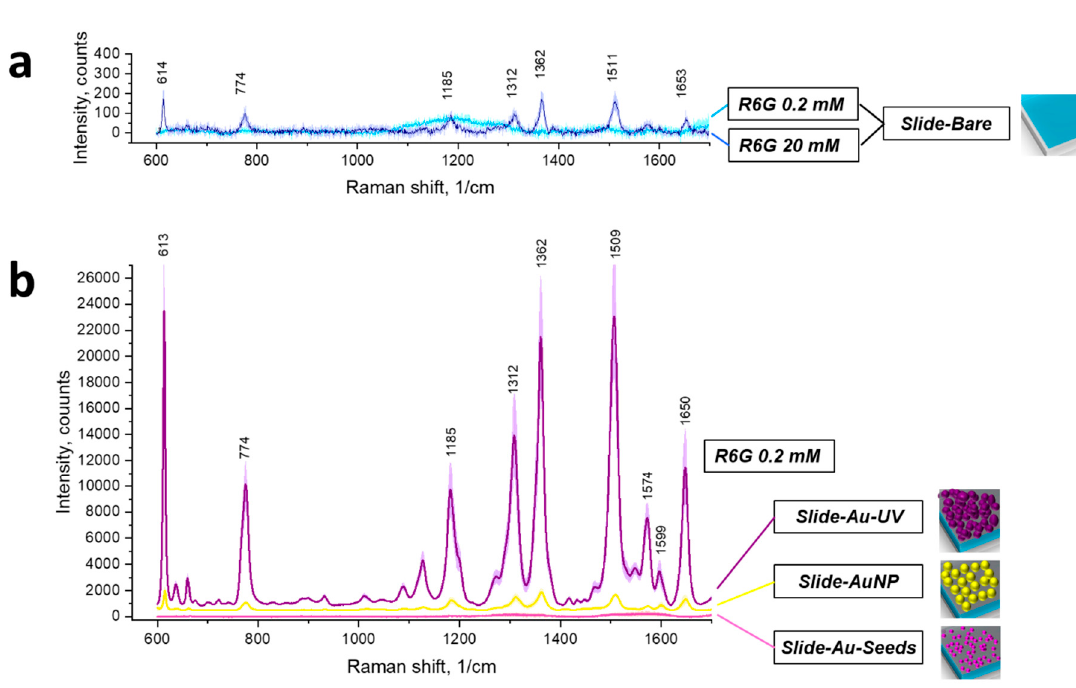
Figure 3. Raman and SERS of Rhodamine 6G (R6G) on planar glass substrates: ( a ) R6G at concentrations 0.2 and 20 mM on a bare glass slide; ( b ) R6G at concentration 0.2 mM on plasmonic substrates.